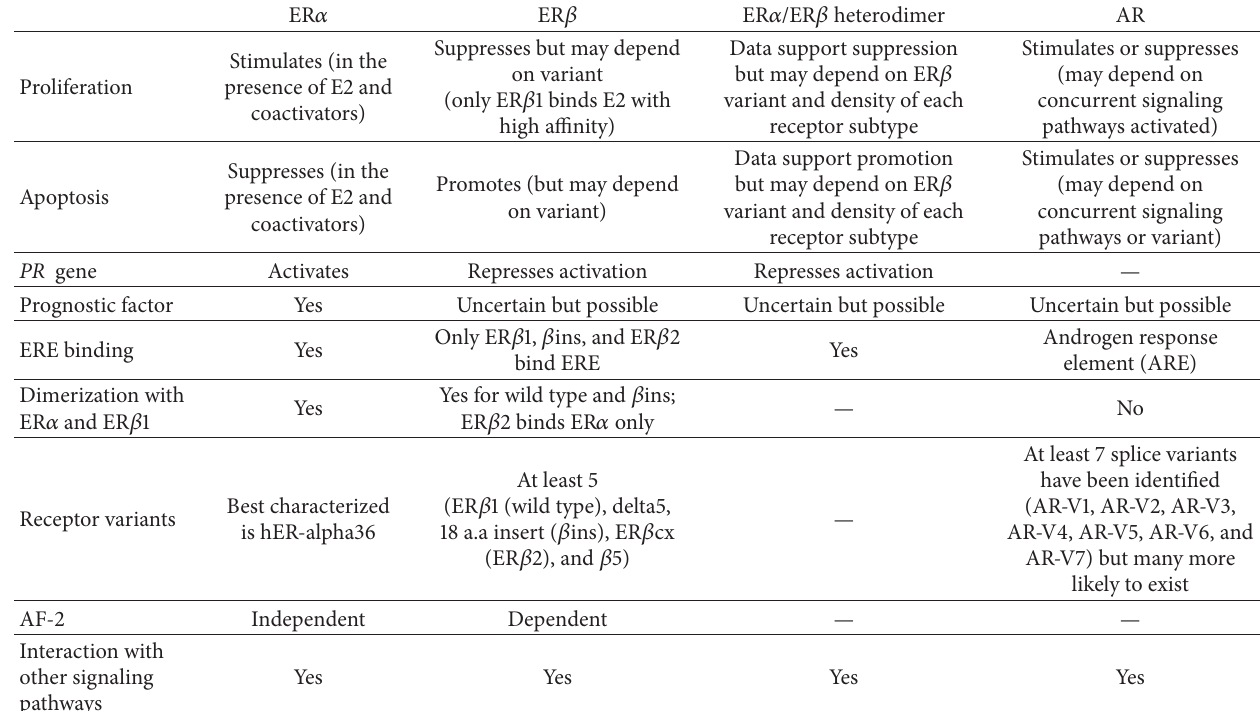
Table 1: Receptor-mediated effects and features in breast